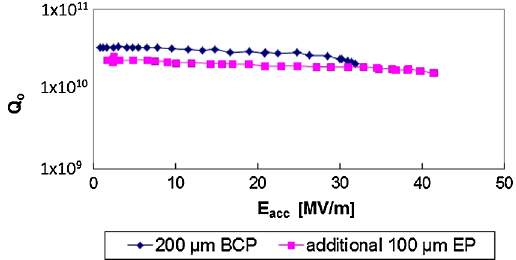
FIG. 29. Q vs E at 2K for cavity 1K2 produced from deep o acc drawn tube after BCP and final EP. RRR100, post purified at 1400 °C. BCP and rf tests done at JLab. EP done at KEK